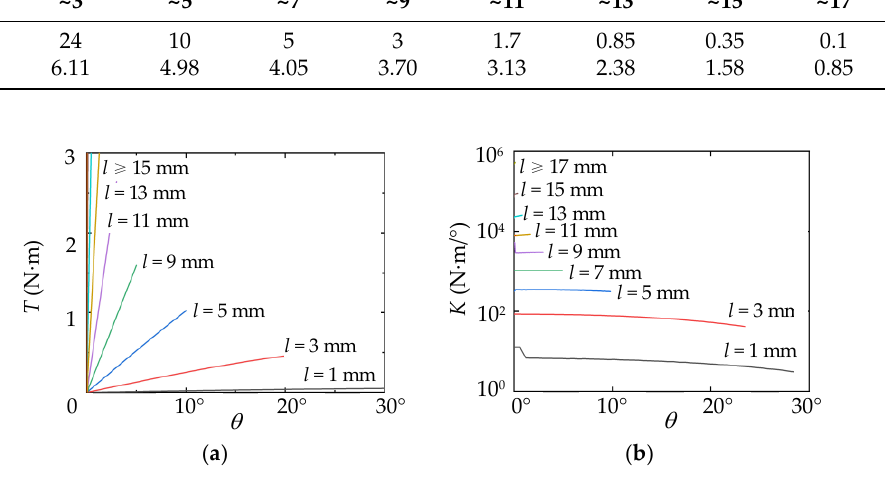
Figure 8 . T and K change with θ and l . ( a ) The relationship curves of T with respect to θ under different values of l . ( b ) The relationship curves of K with respect to θ under different values of l .